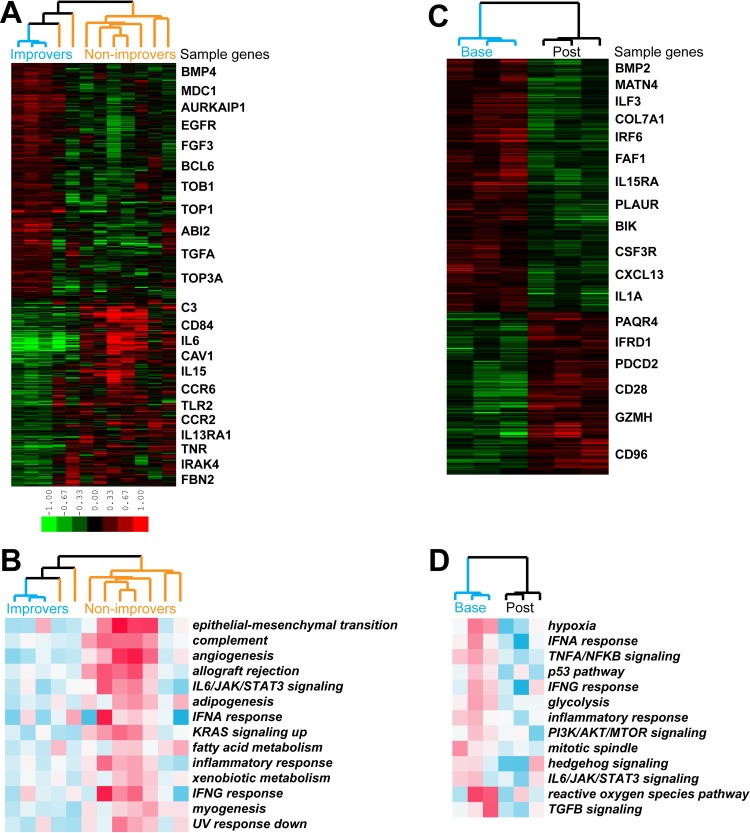
Baseline and improver gene expression and pathway enrichment analysis.(A) 1,062 genes were differentially expressed (p<0.05) between improvers and non-improvers at baseline. Sample color legend: blue–improvers, orange–non-improvers. (B) 14 pathways showing differential expression (FDR<10%) at baseline. (C) 454 genes displaying differential expression (p<0.05) between baseline and post-treatment in improvers. Sample color legend: blue–baseline samples, black–post-treatment samples. (D) 13 pathways were differentially expressed (FDR<10%) in improvers.